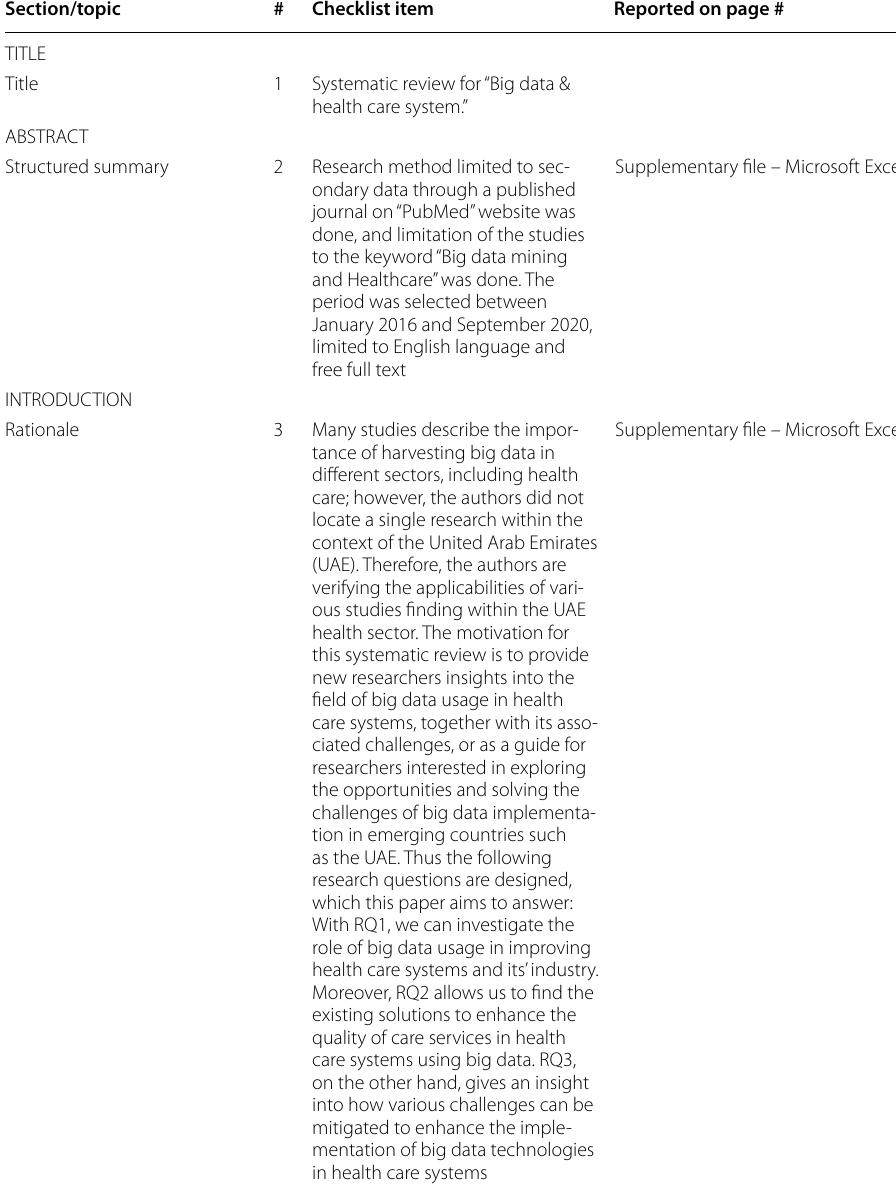
Table 2 PRISMA 2009 Checklist- Big Data